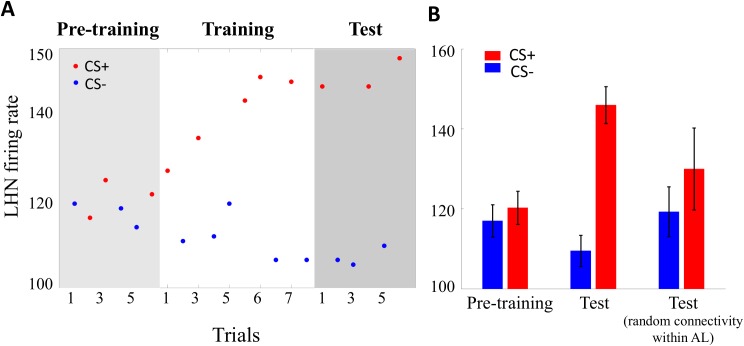
Model performance in differential olfactory conditioning of the proboscis extension reflex.A) Firing rates of the LHN response to a rewarded odour A (CS+) and unrewarded odour B (CS-) during three stages of the PER task; pre-training, training, and test. The red and blue points show responses of the LHN to the CS+ and CS-, respectively. Synaptic strengths between antennal lobe projection neurons to the LHN are modified only during the training (white area). Conditioning the model with CS+ induces increased firing rate in LHN during training. B) Responses of LHN to both CS+ and CS- before and after the conditioning for two different models, one with the structured connectivity and the other with random connectivity within the antennal lobe. The red and blue bars represent the LHN activity for CS+ and CS-, respectively. Standard error (SE) bars were calculated from the LHN’s firing rate for 50 different odours and different initial parameters in the differential conditioning. Bees were able to learn to discriminate significantly between rewarded stimuli and unrewarded stimuli (p-value < 10−6) while bees with random connectivity between local neurons and projection neurons cannot distinguish the CS+ (p-value = 0.29).